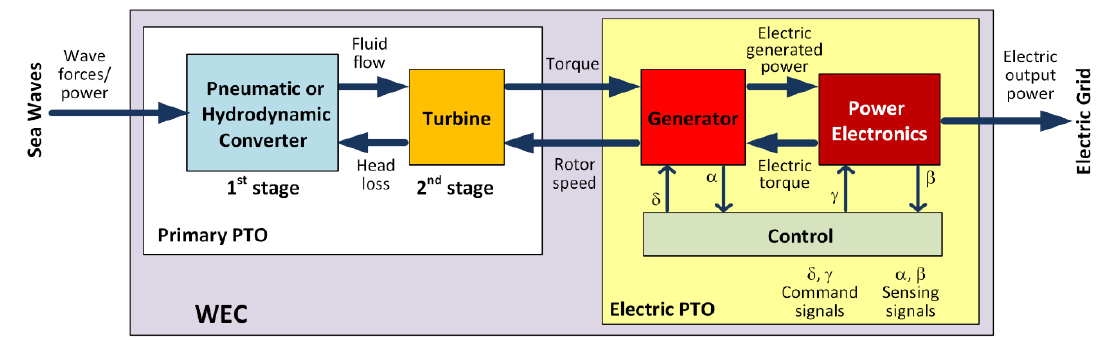
Figure 3. Diagram of the state machine executed by the PLC.